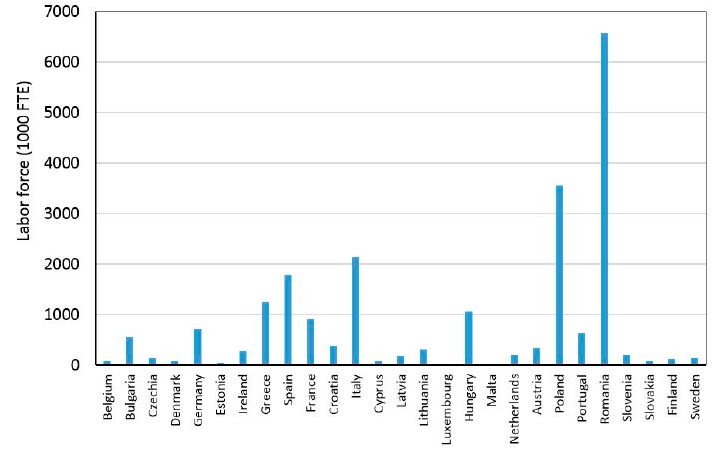
Figure 18. Farm labor force in member countries of the EU in 2013, FTE—full-time equivalents, data obtained from [70].